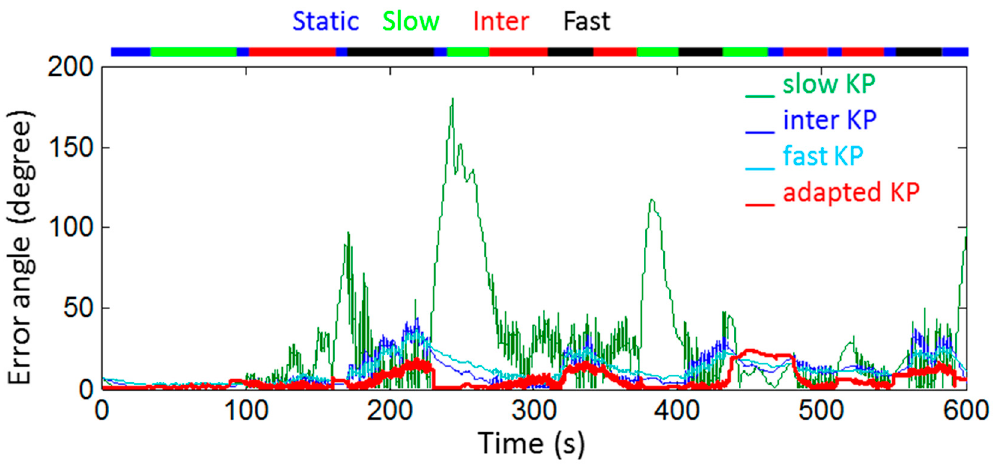
Figure 5. Orientation errors computed during a 10 min movement for orientations obtained with four different settings of the Kalman filter, namely with adapted Kalman parameters and with Kalman parameters identified respectively on slow, intermediate, and fast movements. The orientation obtained with the optoelectronic system served as reference. The color bar at the top of the figure represents the intensity level recorded during the movement.